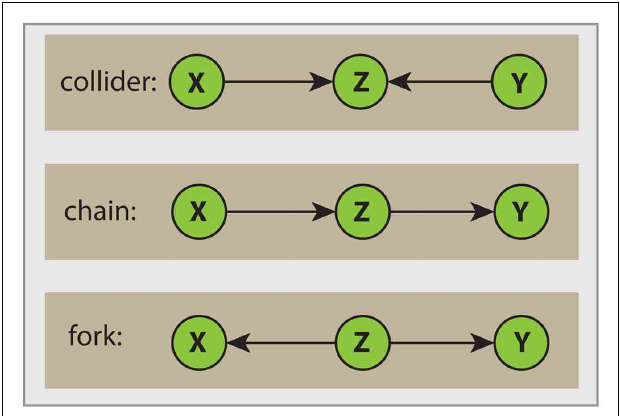
FIGURE 2 |Visualization of different path types. The orientation of edges with respect to the node Z allow the following distinction.Top: collider; middle: chain; bottom: